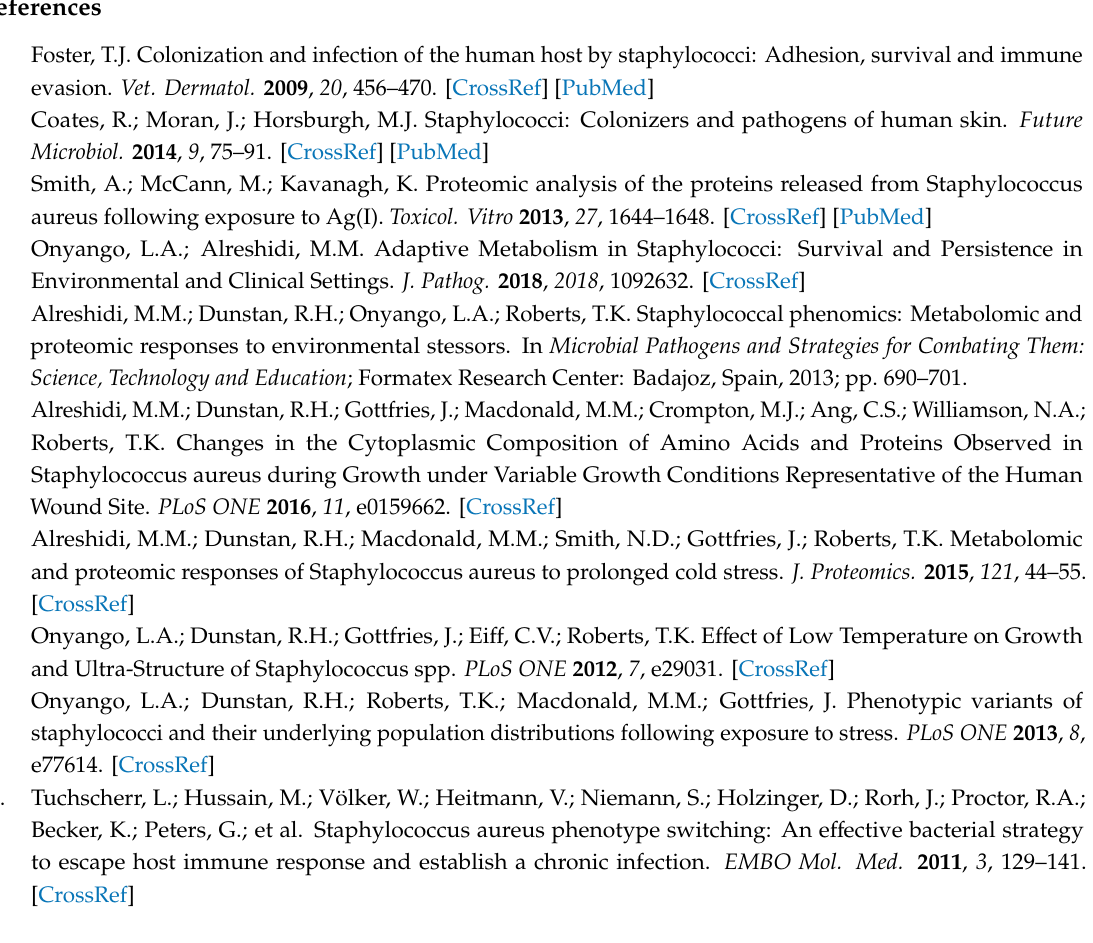
Table S1: Peptide sequences and relative statistical information; Table S2: The sum of all peptide intensities quantified for each